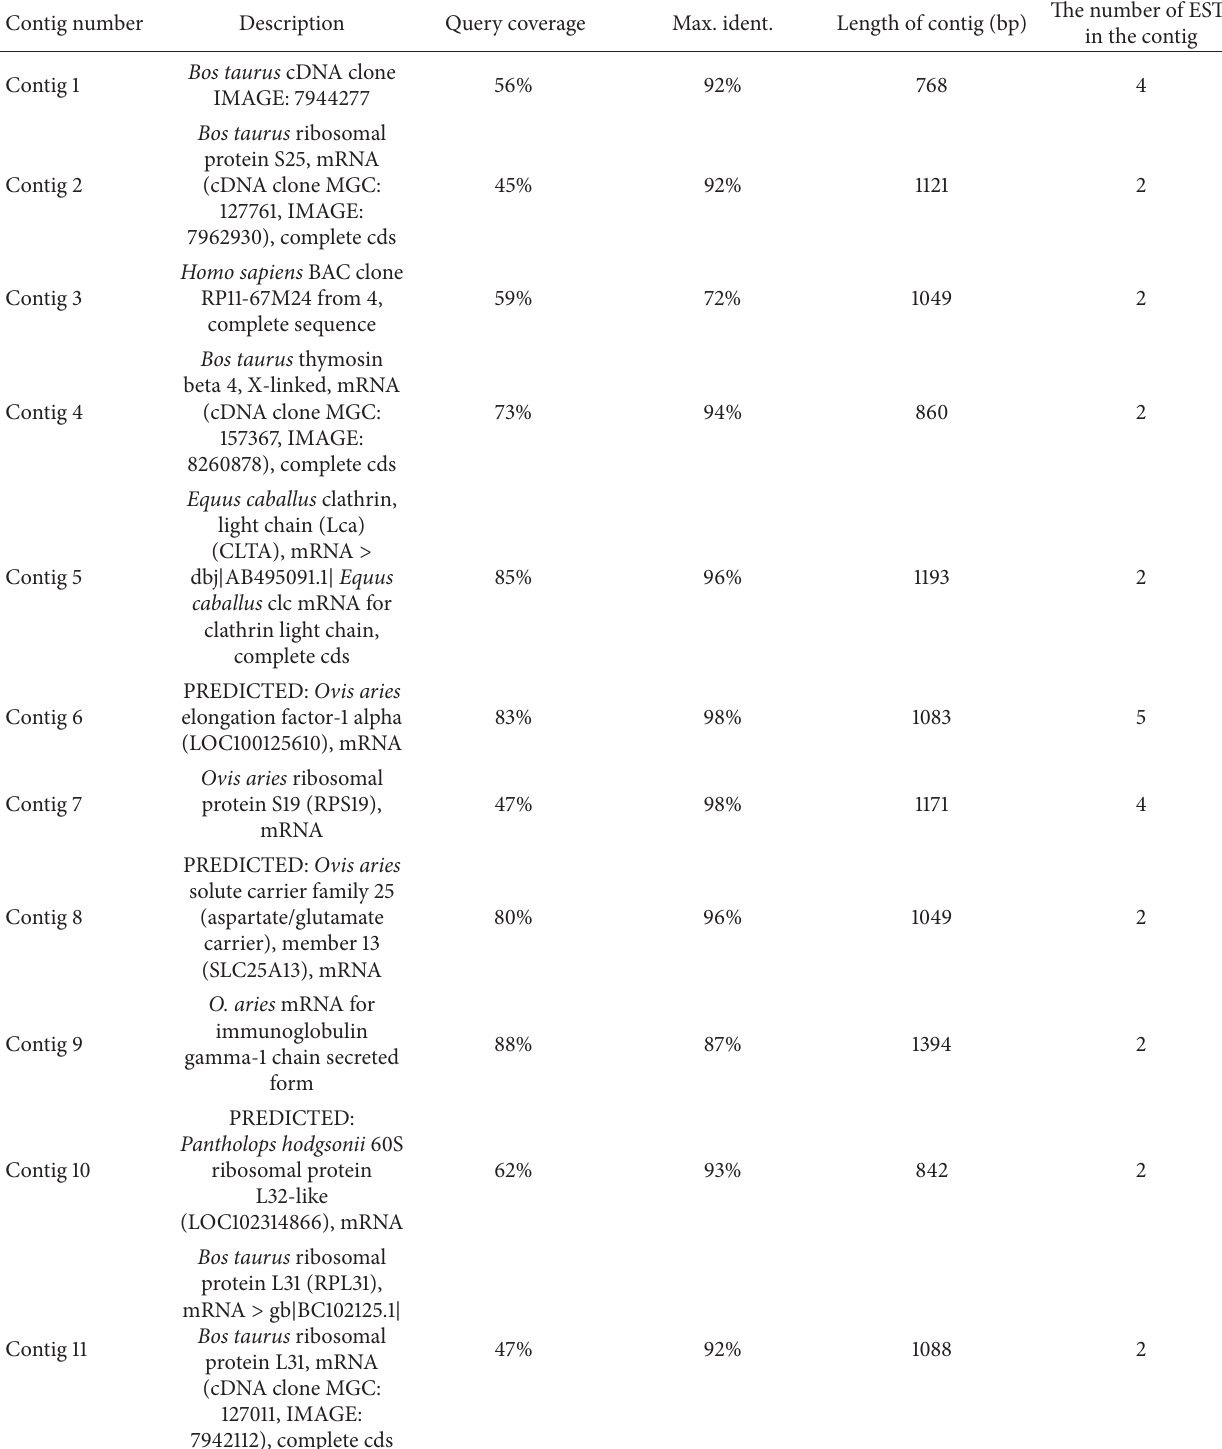
Table 3: The Blastn results of prenatal